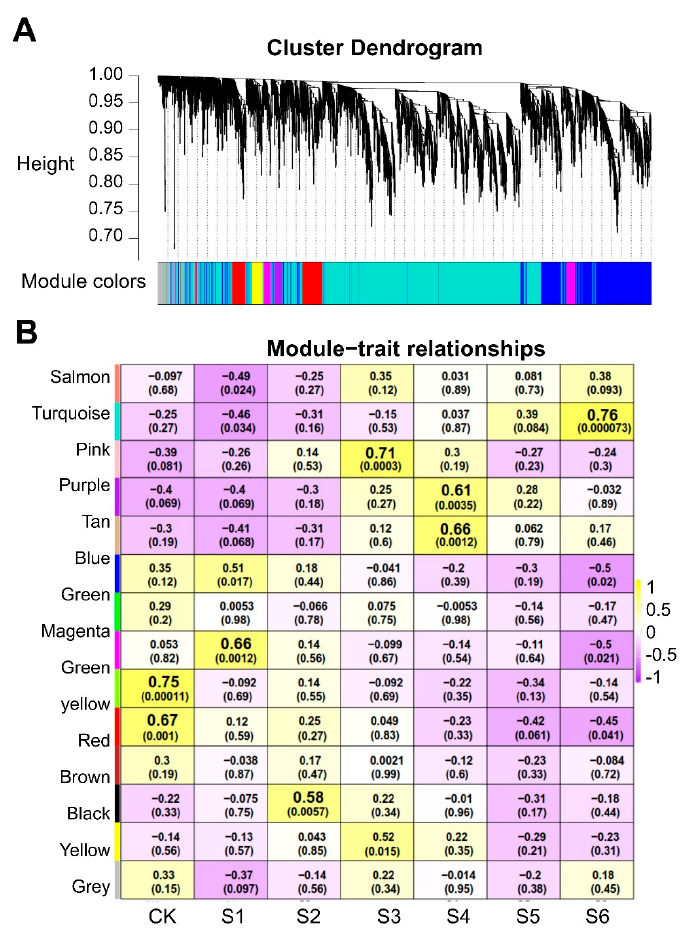
Figure 9. Weighted correlation network analysis (WGCNA) coexpression network and module-trait correlation analysis under salt stress. ( A ) Hierarchical cluster tree showing the coexpression modules. Different colors indicate different modules. ( B ) Correlation analysis between different modules and salt stress duration. The top number in the cell represents the correlation coefficient and the bottom number indicates the p value.